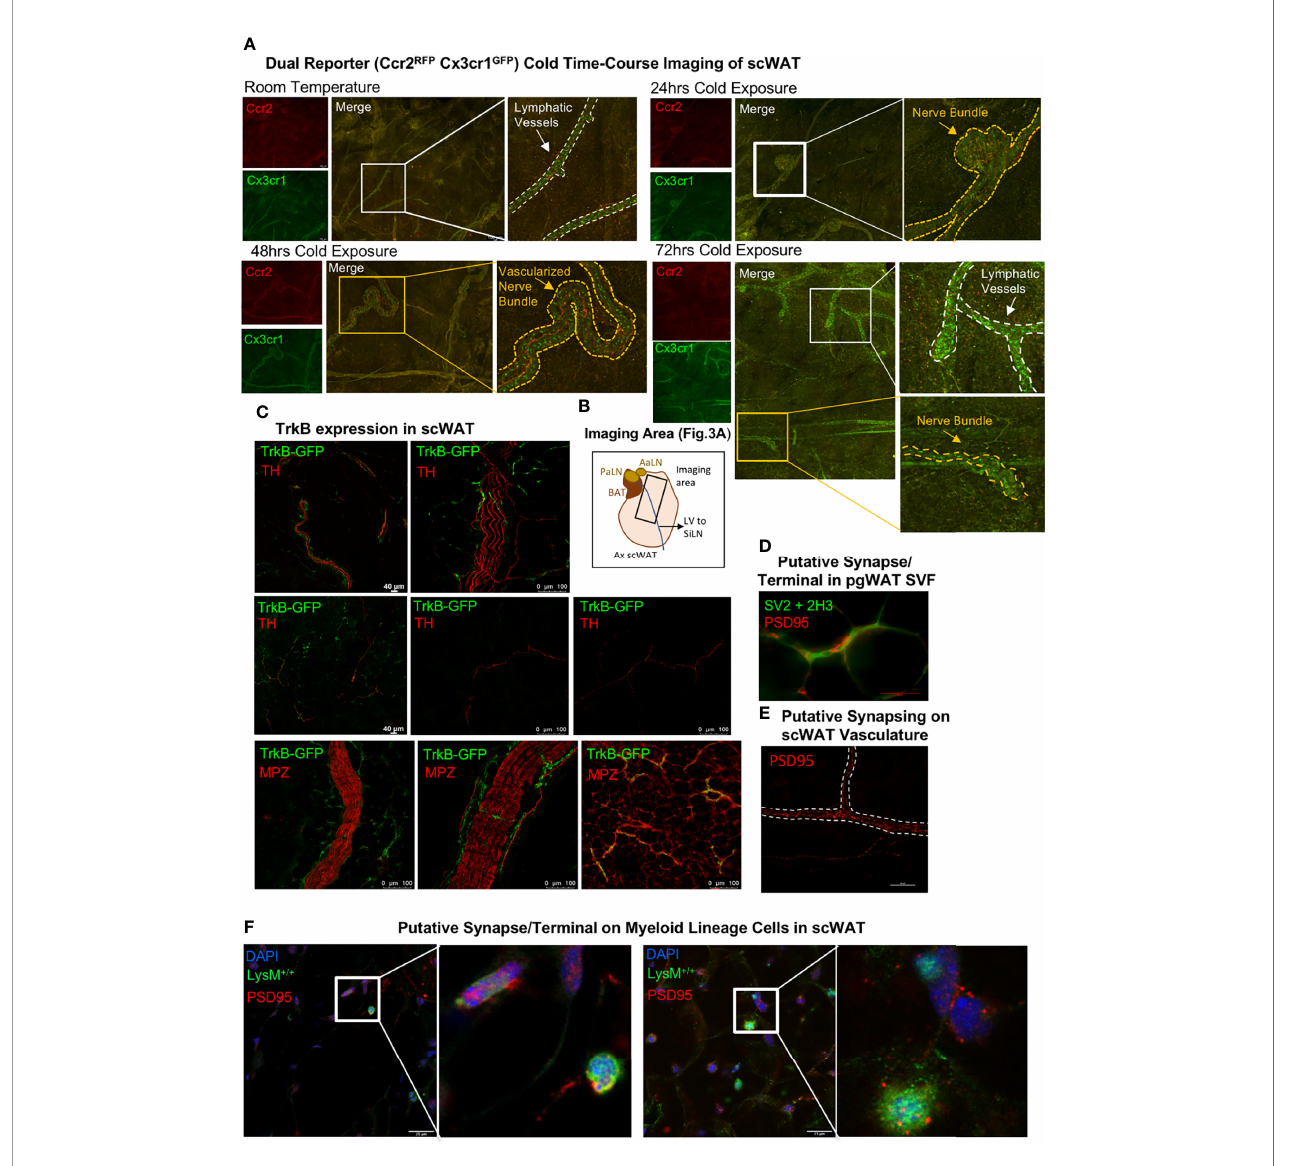
FIGURE 3 | Whole-mount imaging of immune cell traf fi cking, TrkB expression, and identi fi cation of putative synapses in scWAT. (A) Adult (15 – 20 weeks old) male Ccr2 RFP Cx3cr1 GFP dual-reporter mice were maintained at either room temperature ( N = 2) or cold-exposed at 5°C for 24 h ( N = 3), 48 h ( N = 3), or 72 h ( N = 3). scWAT was processed for whole -mount imaging as described in the method section. Tissue was imaged at ×10 on a confocal microscope equipped with white light laser. The images are maximum projections of merged tiled z-stacks. The lymphatic vasculature is outlined by a white dashed line, and the yellow dashed line outlines the nerve bundles. The images shown are representative of each group. (B) Schematic of the axillary scWAT imaged in ( A ). The black rectangle represents the area imaged. PaLN, proper axillary lymph node; AaLN, accessory axillary lymph node; BAT, brown adipose tissue; LV, lympthatic vessel; SiLN, subiliac lymph node. (C) Whole-mount imaging of TrkB expression in scWAT. scWAT from adult male Trkb GFP reporter mice was immunolabeled with anti-GFP and either tyrosine hydroxylase or myelin protein zero and imaged by confocal microscopy at ×10 and ×20. (D) Perigonadal white adipose tissue from adult C57BL/6J mice was whole- mount processed and immunostained with markers for neuro fi lament and synaptic vesicles to identify the pre-synaptic axon terminal and the post-synaptic marker PSD95 (red). Imaged with ×40 objective lens on a Nikon E400 microscope. (E) Whole-mount imaging of scWAT immunostained with PSD95 revealed potential synapsing along a blood vessel (dashed white border). Imaged with ×40 objective lens using extended depth of fi eld (NIS-Elements) on a Nikon E400 microscope. (F) Putative synapses on myeloid-lineage cells from LysM-Cre-Rosa YFP reporter mice. Tissues were co-stained with post-synaptic markers, PSD95 and DAPI, and imaged by confocal microscopy at ×63; z-max projections are shown. The inset is a digital zoom on PSD95 expressing myeloid-lineage